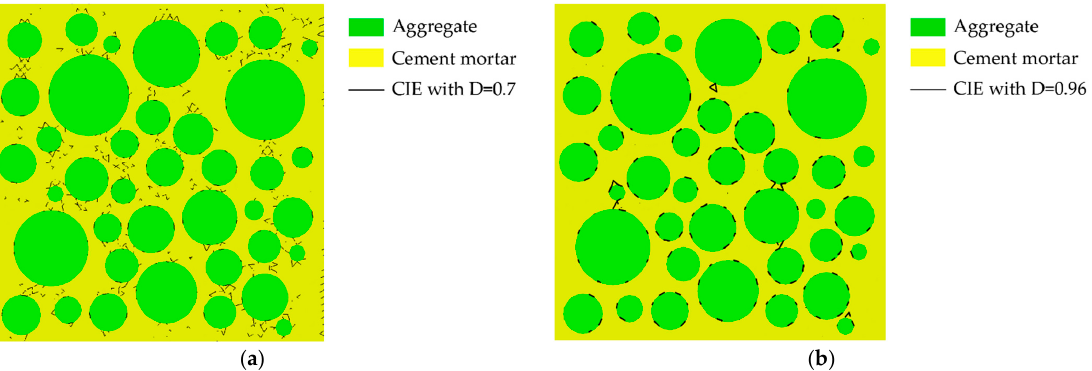
Figure 8. The distribution of CIEs with D = 0.7 and D = 0.96 when σ / σ max ≈ 0.98, ε < ε p . ( a ) D = 0.7; ( b ) D = 0.96.